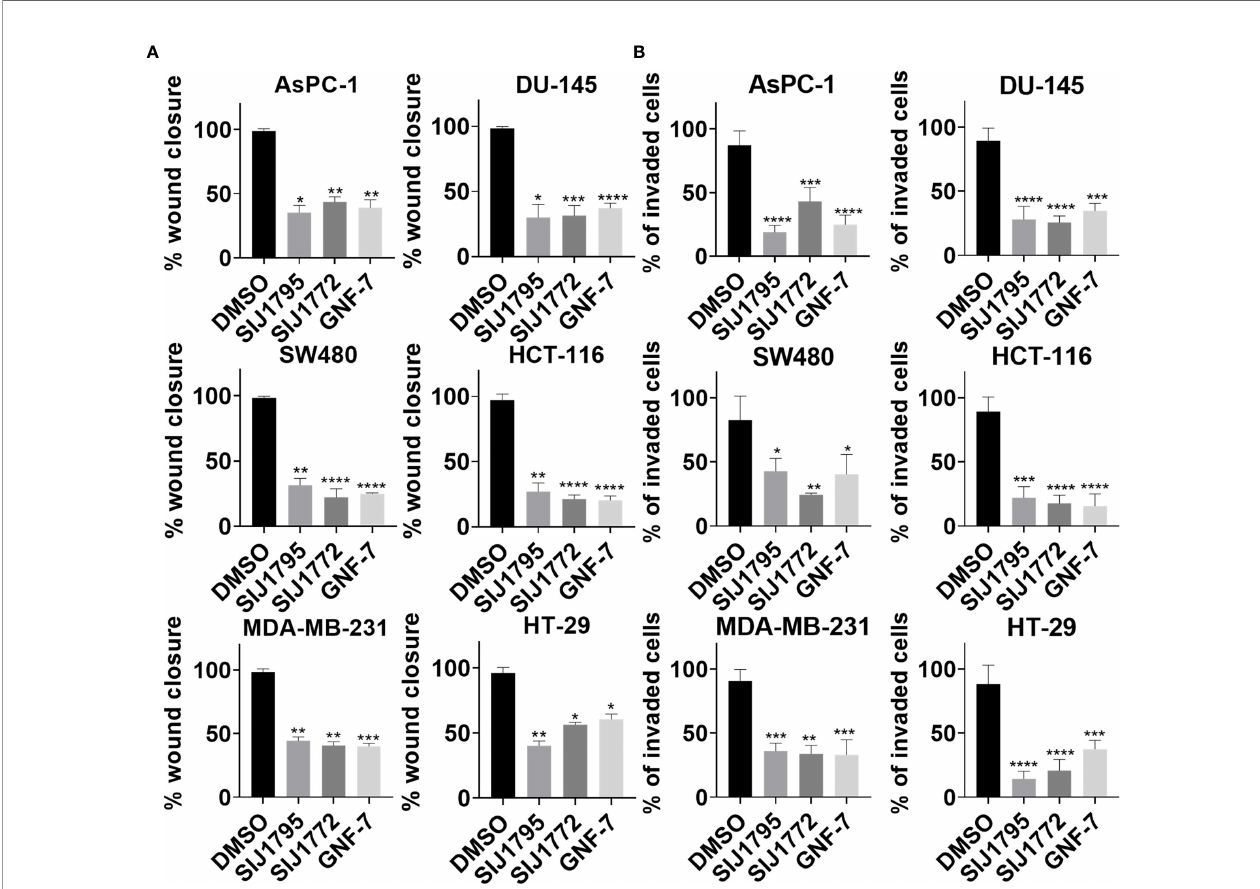
FIGURE 6 | The effects of SIJ1795 and SIJ1772 on migration and invasion activities of cancer cells harboring mtRAS. (A) Scratch assay result for cell migration ability determination. Each cell monolayers were scratched and incubated with test compounds at 0.01 m M. After 8 h (MDA-MB-231) or 24 h (DU-145, SW480, HCT-116) or 48 h (AsPC-1) or 72 h (HT-29), cells were stained with crystal violet. Migrated areas were photographed with 40× magni fi cation. Migrated area was determined by ImageJ (n = 3). (B) Boyden chamber assay result for cell invasion ability determination. Indicated compounds of 0.01 m M were treated and incubated for 48 h Invaded cells were stained by crystal violet and photographed. Stained cells were counted by ImageJ (n = 3). Statistical signi fi cance was determined using a one-way ANOVA analysis (*p < 0.05, **p < 0.01, ***p < 0.001, ****p <